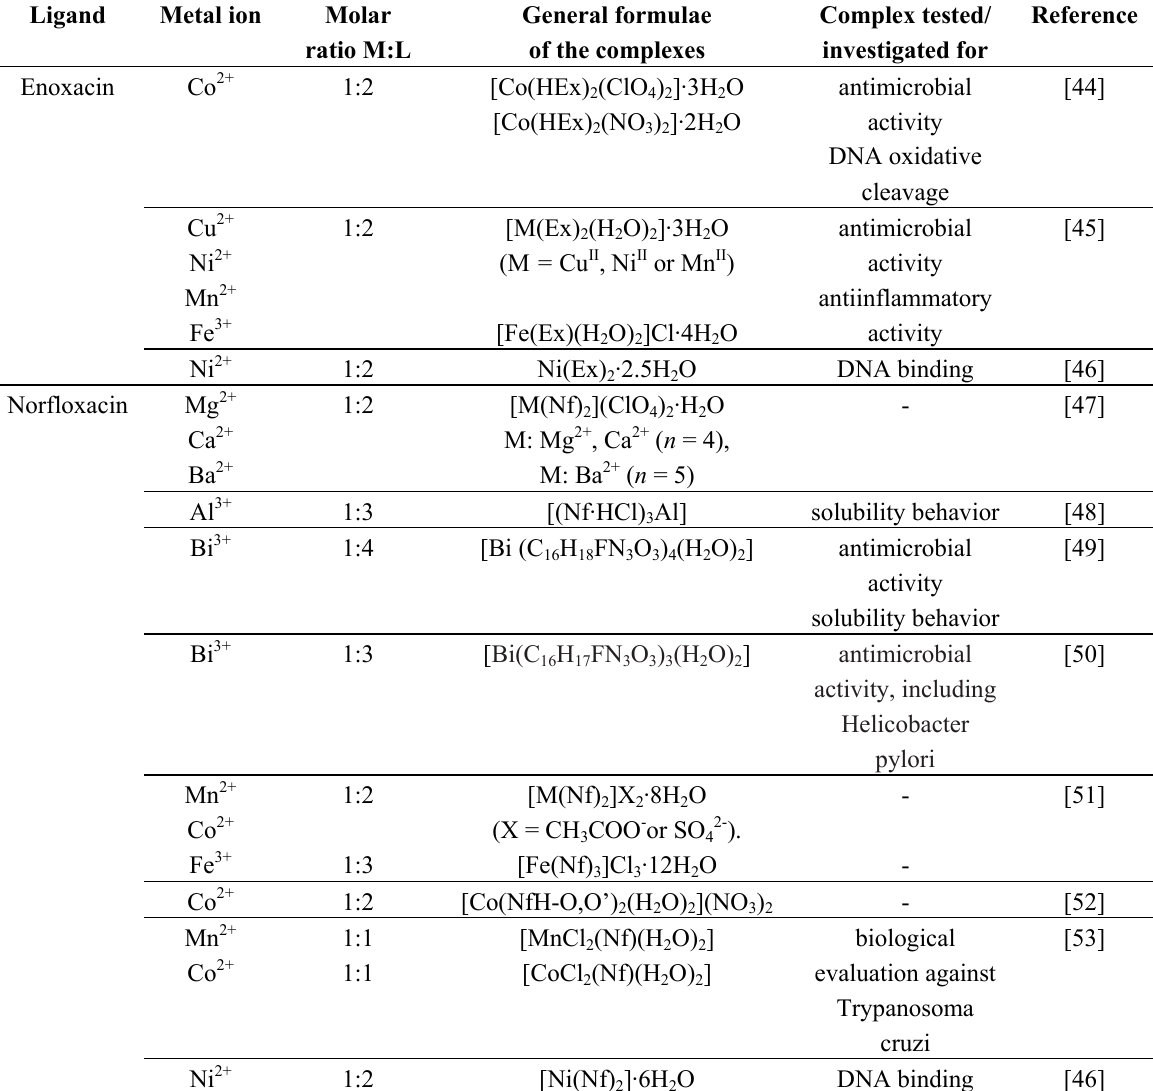
Table 5. Selected chelates of quinolones from second